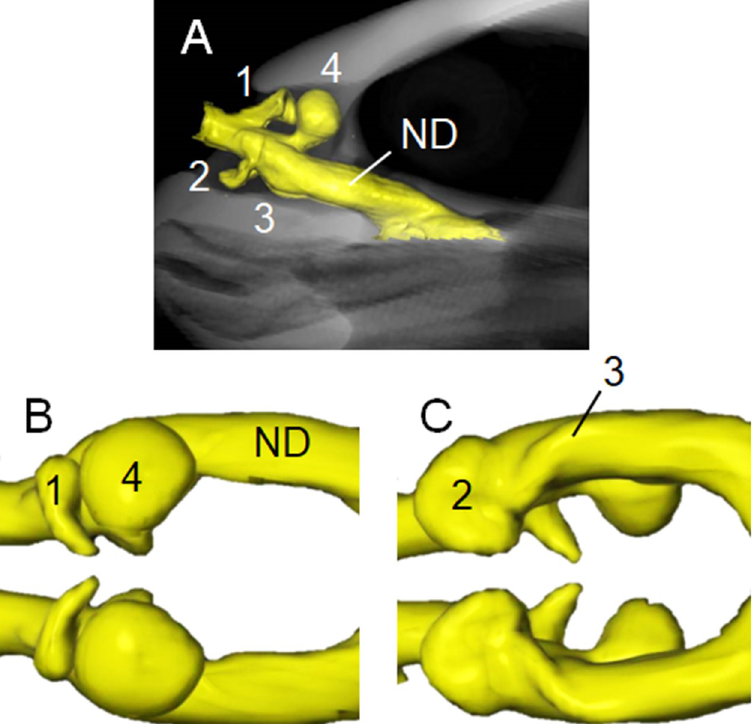
Fig 2. Three-dimensional reconstructions based on computed tomography images of nasal cavity of hawksbill sea turtle. (A) Left lateral view of internal nasal cavity (yellow) at anterior region of skull. Dorsal (B) and ventral (C) views of nasal cavity. Anterodorsal (1), posterodorsal (4) and anteroventral (2) diverticula, and small posteroventral salience formed by fossa on wall (3) in cavum nasi proprium anterior to nasopharyngeal duct (ND). See also S1